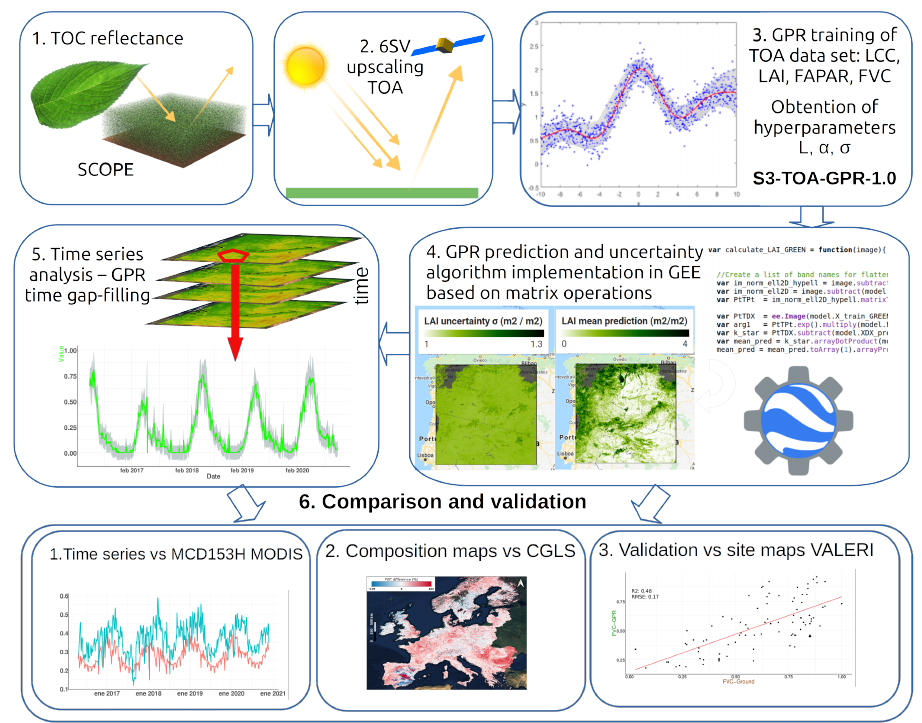
Figure 1. Retrieval workflow for derivation of LCC, LAI, FAPAR and FVC, and S3-TOA-GPR-1.0 model implementation in GEE for mapping, time series generation as well as validation strategies. Table 1. Biochemical leaf and canopy structure variables used for SCOPE simulations. See [6] for details about default